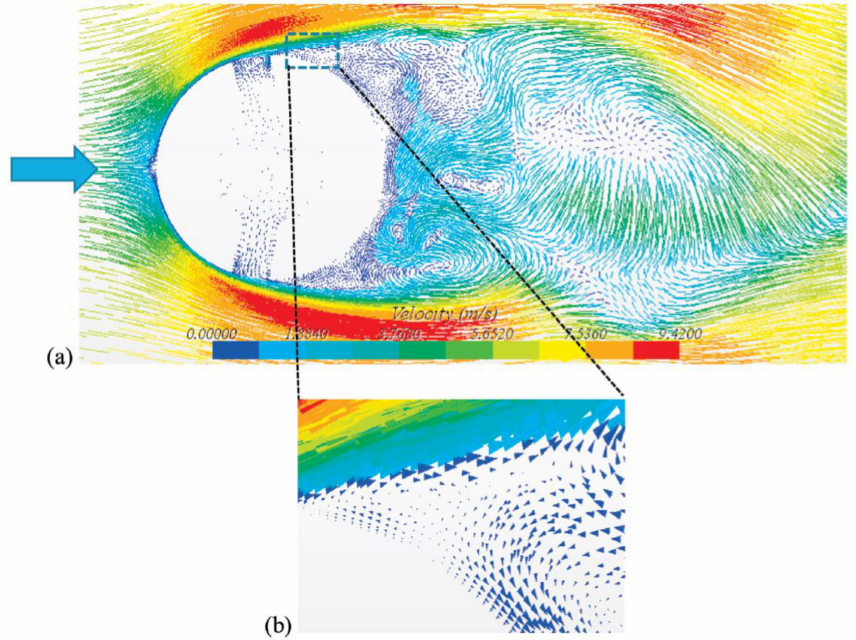
Figure 11. ( a ) Rapid velocity values near the pillar at Re = 2060, t = 0.07 s, ( b ) zoomed view of secondary flow zone on pillar